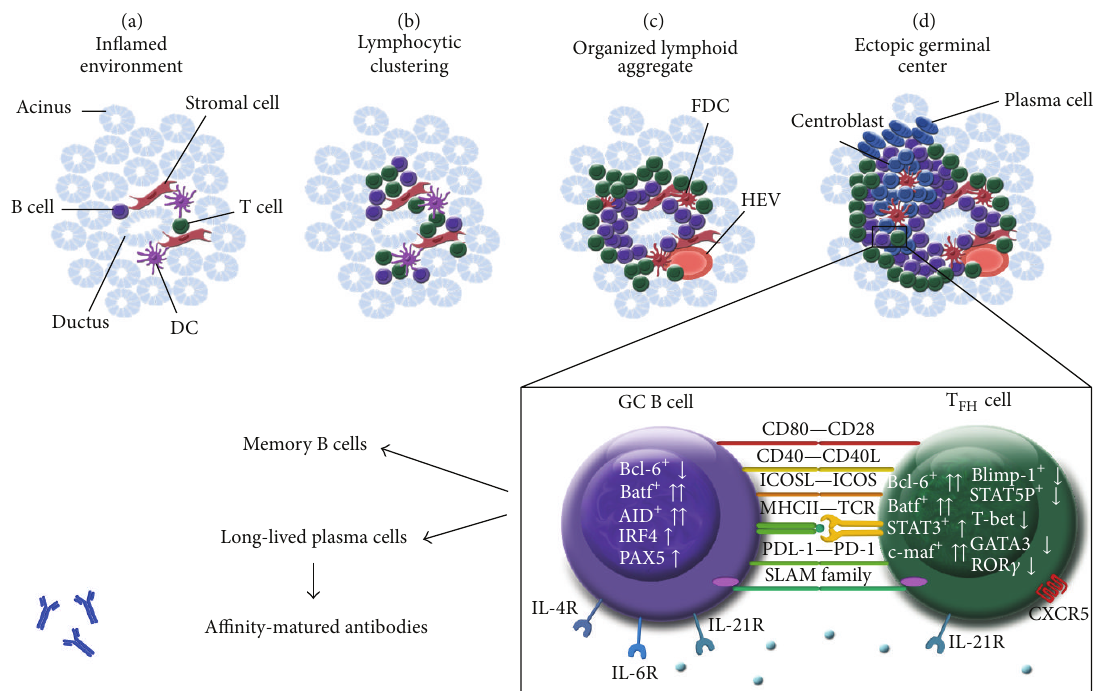
Figure 5: Graphical summary of ectopic lymphoid-like structure organization in exocrine tissue of patients with pSS. During the initiation phase of inflammation, activated T, B, and DC cells accumulate around ductal epithelial structures (a). Inflammatory responses, including chemokine signals by stromal cells can elicit the formation of more organized lymphoid structures (b) and (c). Aggregates with the highest organization level display separated T- and B-cell-rich areas with a central network of FDCs, which correspond to ectopic GCs (d). GC localized T FH cells are characterized by CXCR5, ICOS, PD-1, CD40L, and SLAM family members as CD84, SAP, and IL-21. The interplay between T FH and GC B cells is essential for the formation and maintenance of ectopic GCs, moreover for the generation of memory B cells and long-lived plasma cells. DC: dendritic cells; FDC: follicular dendritic cells; GC: germinal center; HEV: high endothelial venule; SAP: SLAM-associated